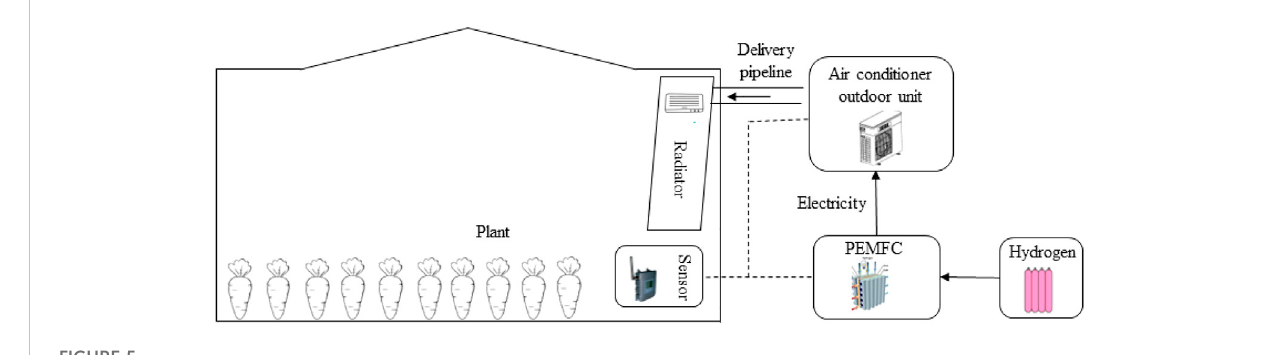
FIGURE 5 Greenhouse energy system of hydrogen.